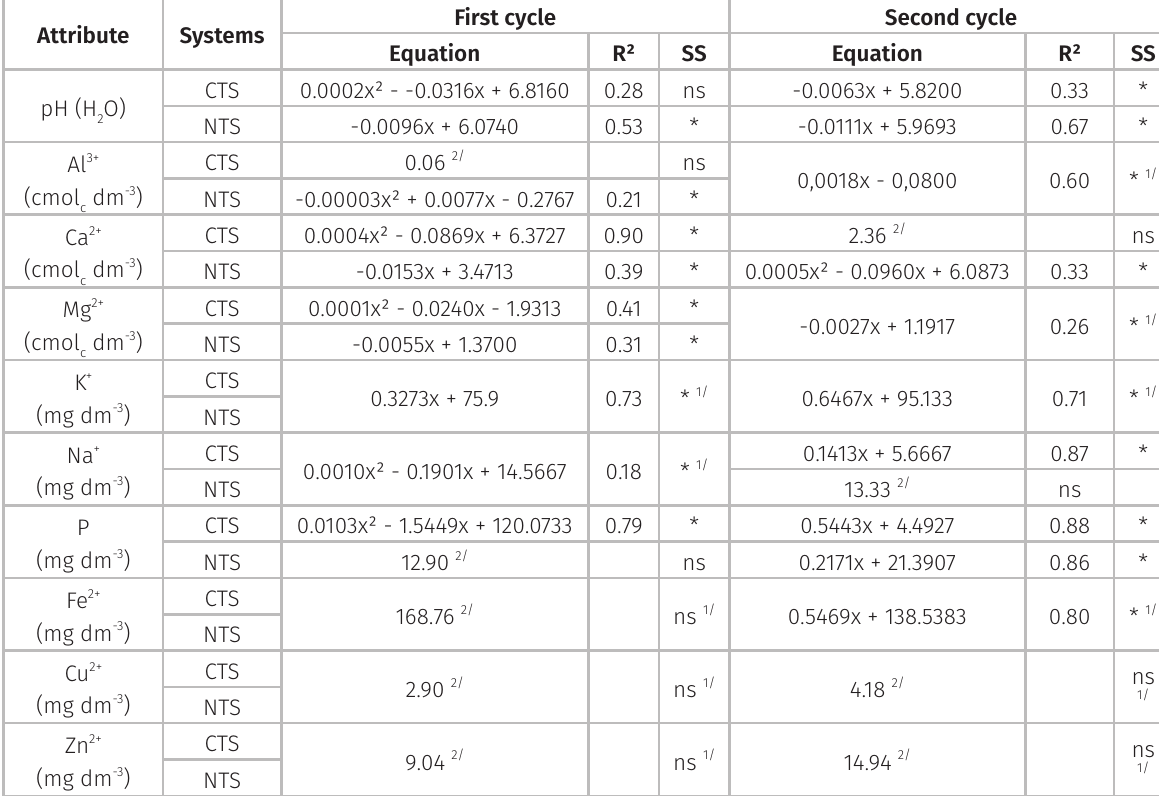
Table VI. Regression equations adjusted between chemical soil attributes as dependent variables of depth